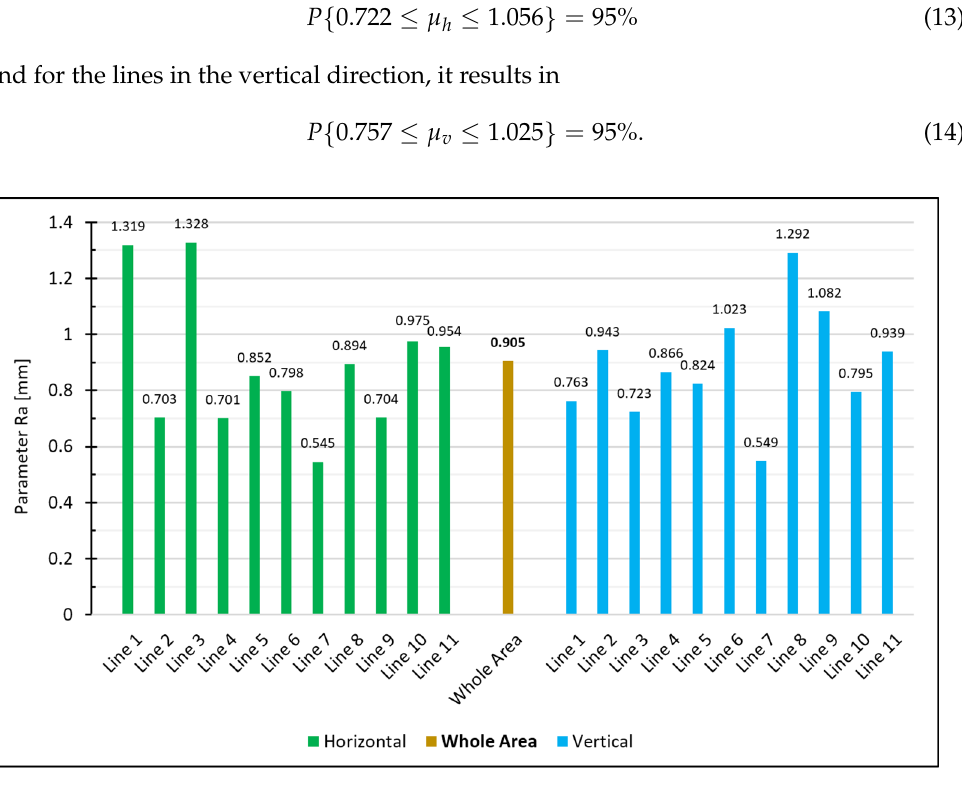
Figure 21. Calculated R a for the extracted lines and for the whole area. A normally distributed measurement series of the lines would lead to 5% of the values falling outside the 95% confidence interval (meaning either no line or just 1 line should fall outside the interval). However, in our case, six of the horizontal lines and four of the vertical lines do not fall into the calculated interval for the expected mean of the measurement series. Accordingly, the assumption that the individual profile lines are only subjected to normally distributed noise does not apply. Thus, the deviations of the lines can no longer be justified just stochastically, and this brings us to the conclusion that a single line is unsuitable to specify the roughness of an entire surface. An area-based determination, on the other hand, enables a reliable estimation of the roughness since all measuring points of the entire surface are concerned in the calculation.